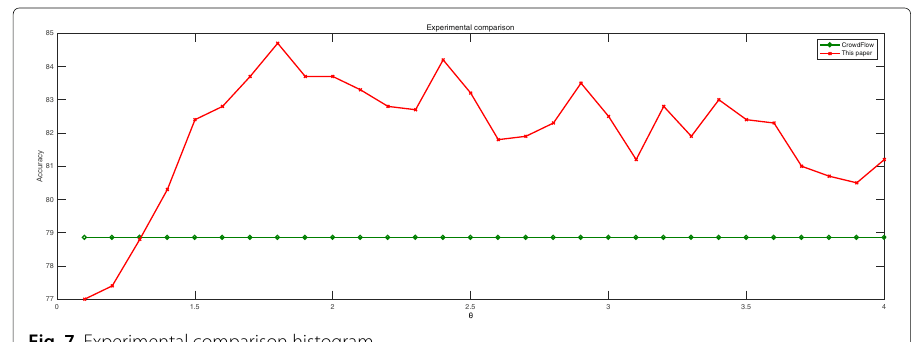
Fig. 7 Experimental comparison